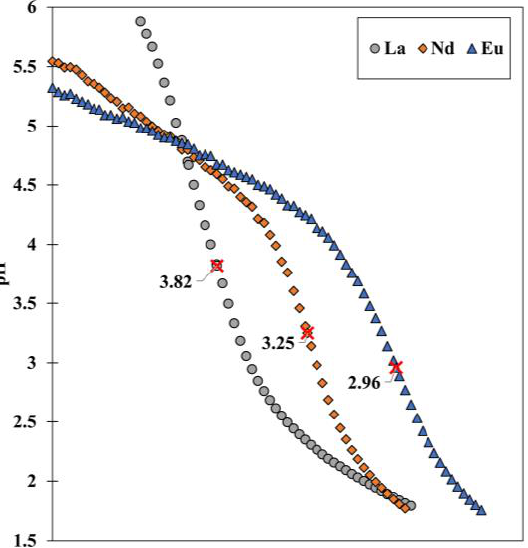
Figure 9. Titration curves of the individual MGDA-REE complexes. The pKa values of the equivalent points are marked on the titration curves. Grey = La (3.82), orange = Nd (3.25), blue = Eu (2.96) (titrant = 10 mM HCl; fixed speed titration; T = 298 ± 2 K).